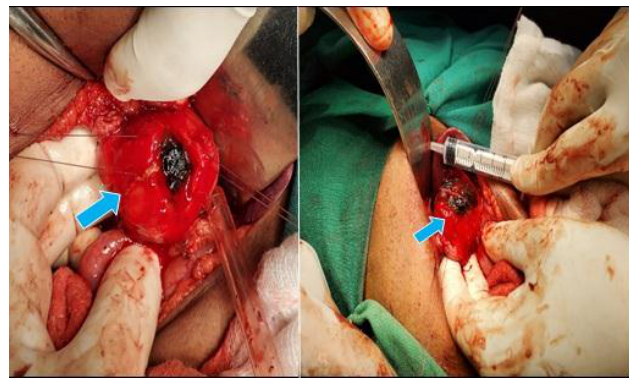
Figure 5: Intra-operative photos of two stay stitches and appropriate longitudinal CBD incision suitable for giant stone